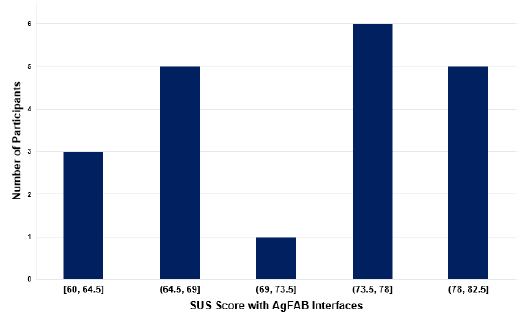
Figure 6. Histogram of SUS Score (with AgFAB)